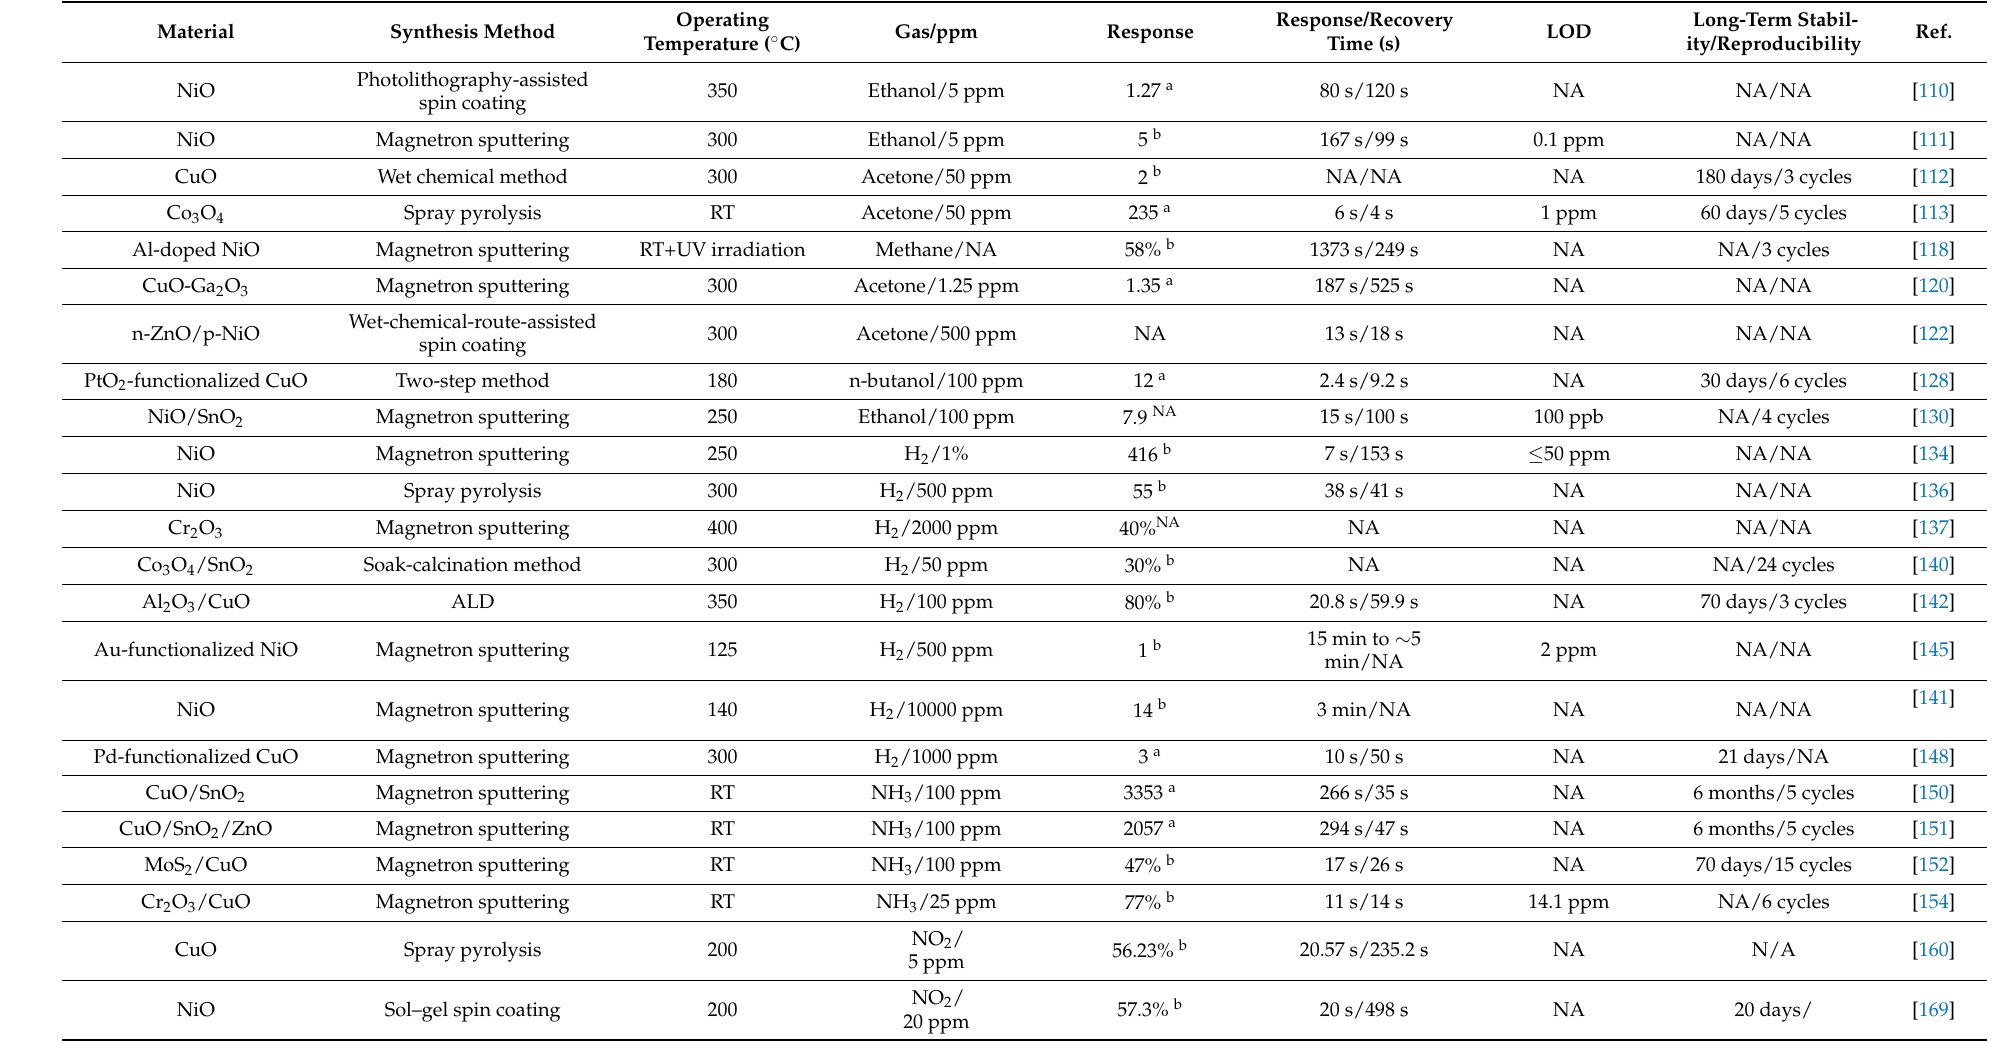
Table 1. Sensing performance of p-type MOX towards reducing and oxidizing